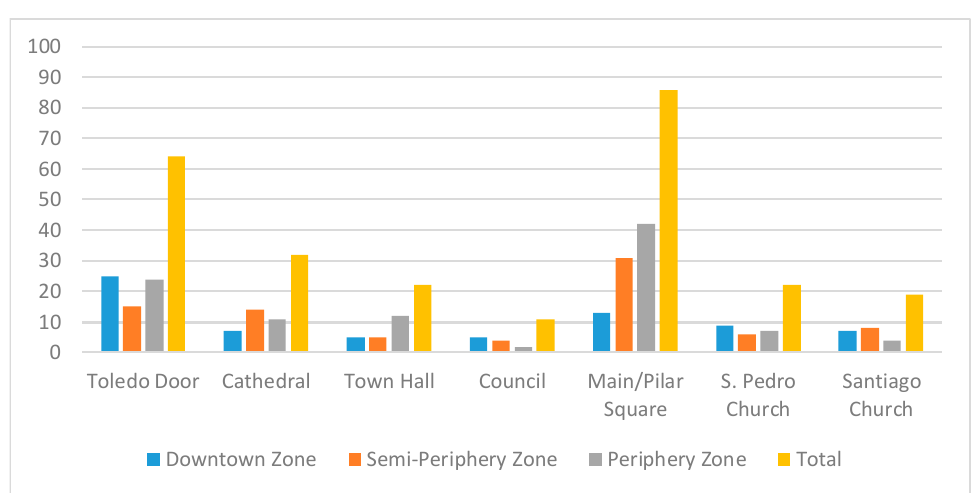
Figure 3. Descriptive results of answers. Source: Own work.